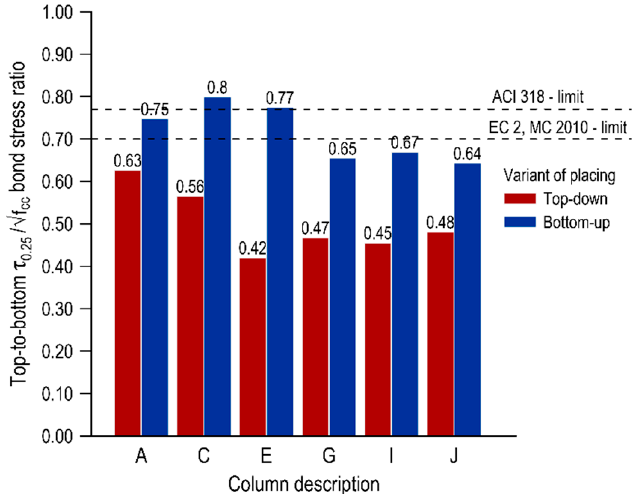
Figure 6. Top-to-bottom ratio for normalized critical bond stresses.